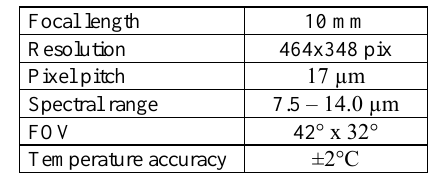
Table 1. Parameters of thermal imaging camera FLIR